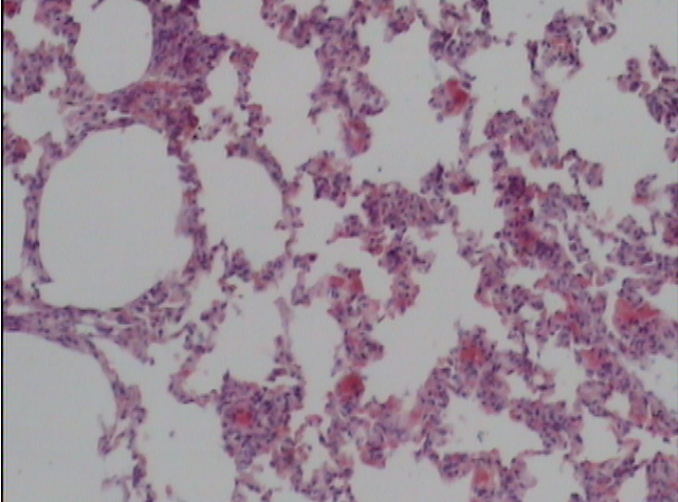
Figure 1. Control group.